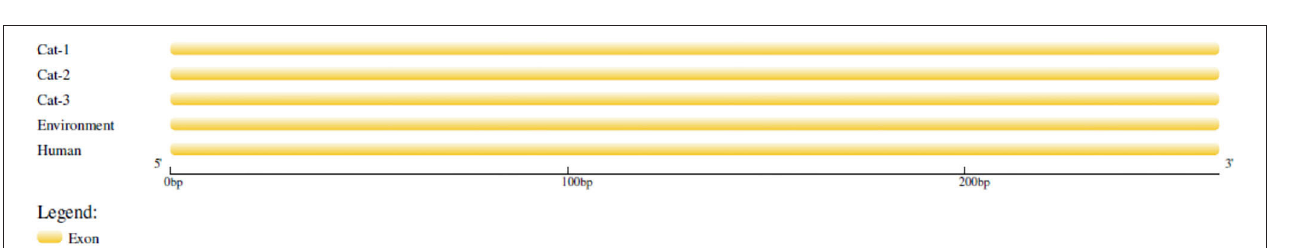
FIGURE 8 | Gene structure of Staphylococcus aureus mecA gene amplified fragment.